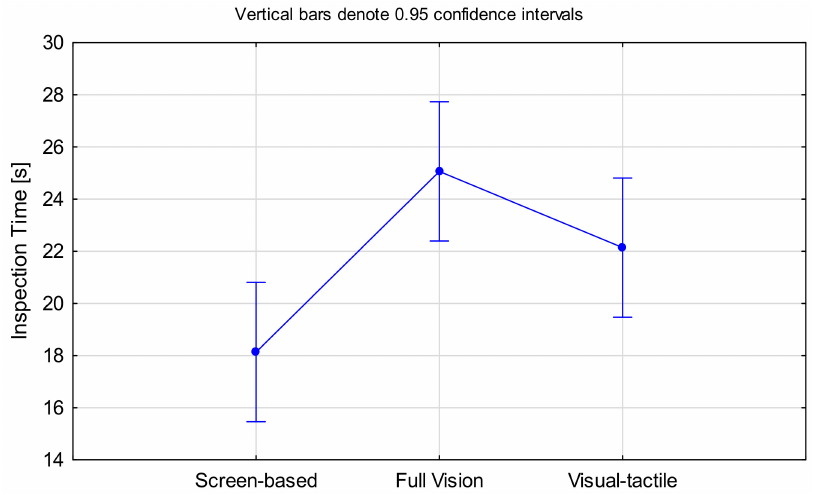
Figure 4. Mean plot of inspection time by inspection method.